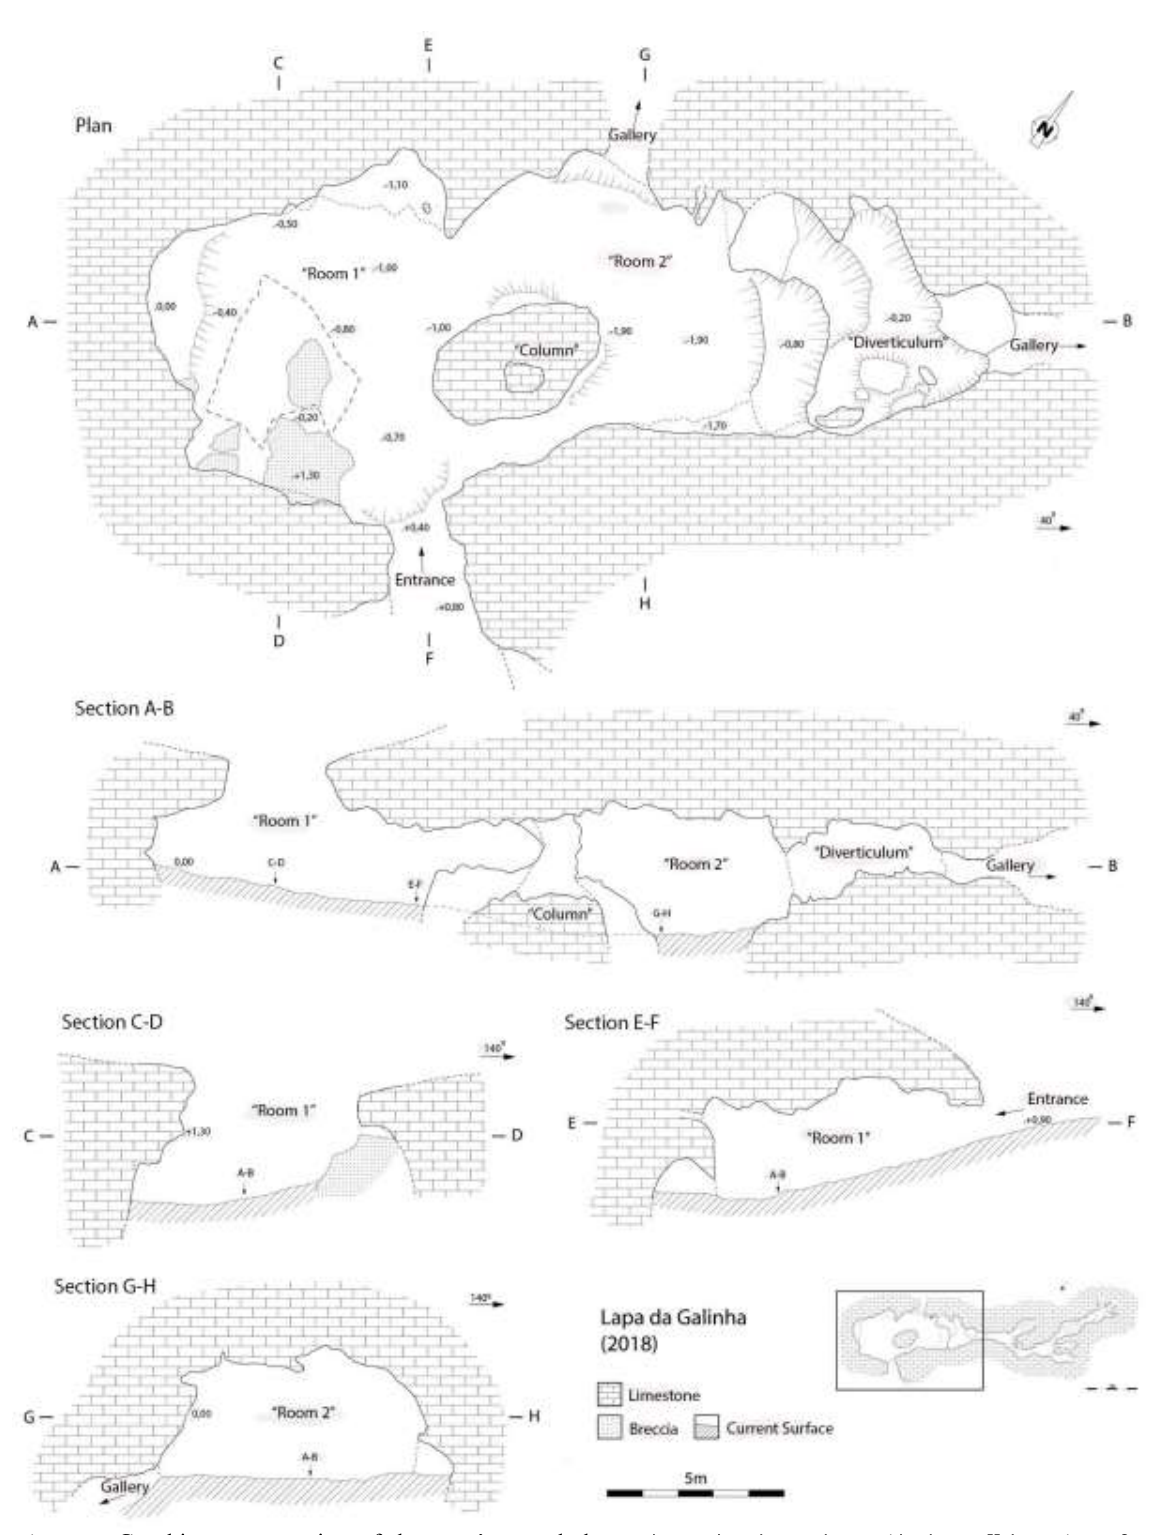
Figure 3. Graphic representation of the cave’s morphology, drawn by the author with the collaboration of a various number of colleagues (January and April 2018). The scale bar segments are 5 m each (25 m long in